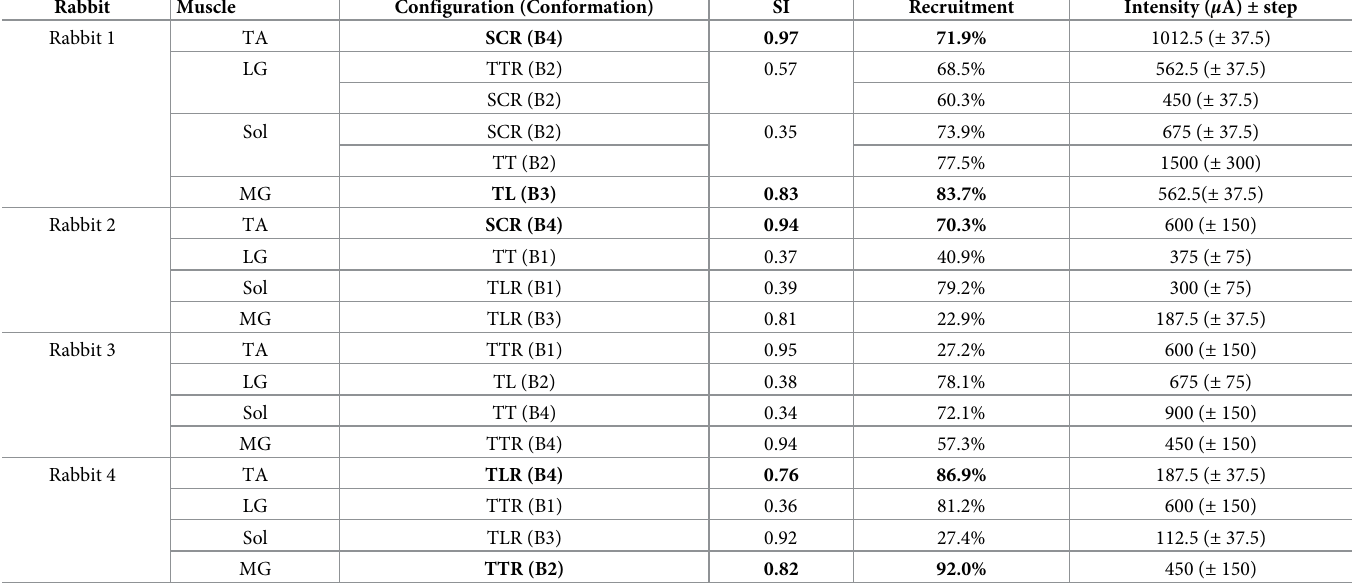
Table 3. Maximum SI obtained for each rabbit, configuration and muscle. Bold numbers indicate that SIR is fulfilled. Rabbit Muscle Configuration (Conformation)